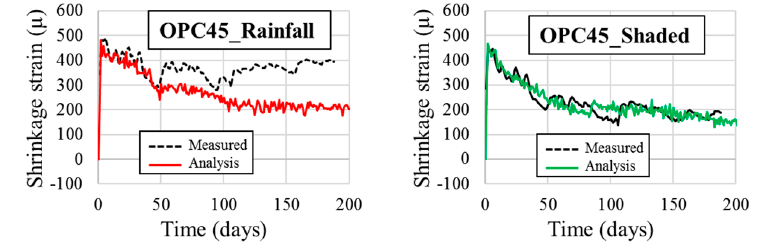
Figure 6. Concrete shrinkage strain of OPC45.